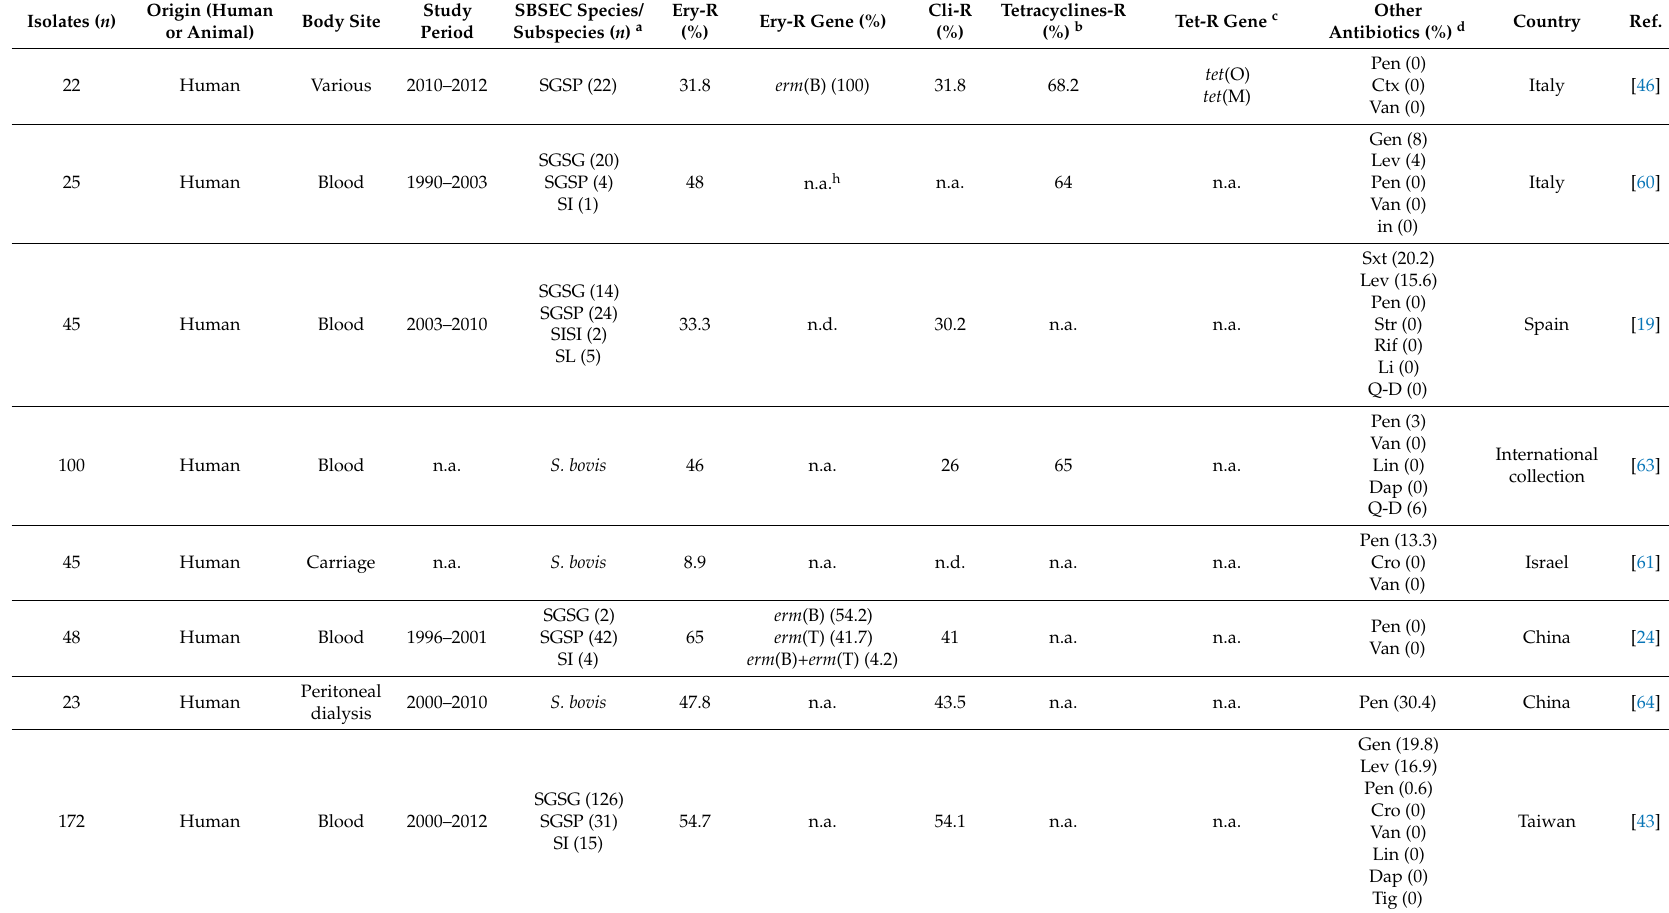
Table 2. Antibiotic resistance rates and resistance genes reported in the literature regarding species belonging to the Streptococcus bovis/Streptococcus equinus complex